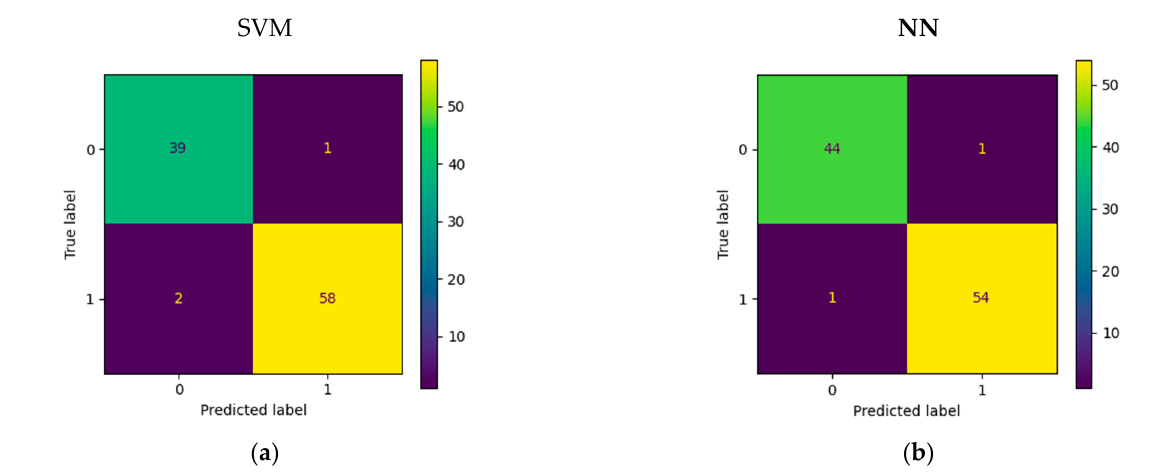
Figure A1. Standard algorithm confusion matrixes; ( a ) SVM classifier; ( b ) NN classifier. Figure A2 shows the confusion matrices obtained with the DL approaches. Model based on MobileNetV2 (a) and ResNet50 (b) is compared. Dates are obtained on the test split of the “Teeth dataset.”